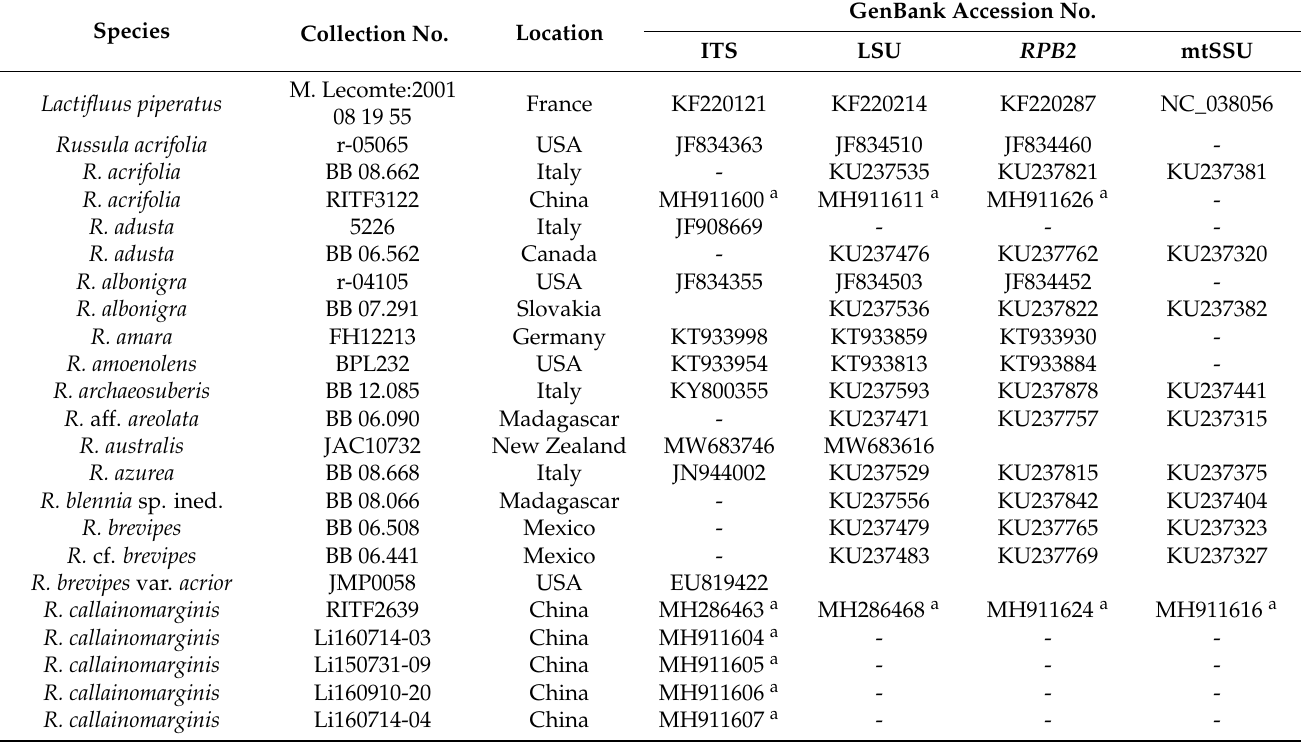
GenBank Accession